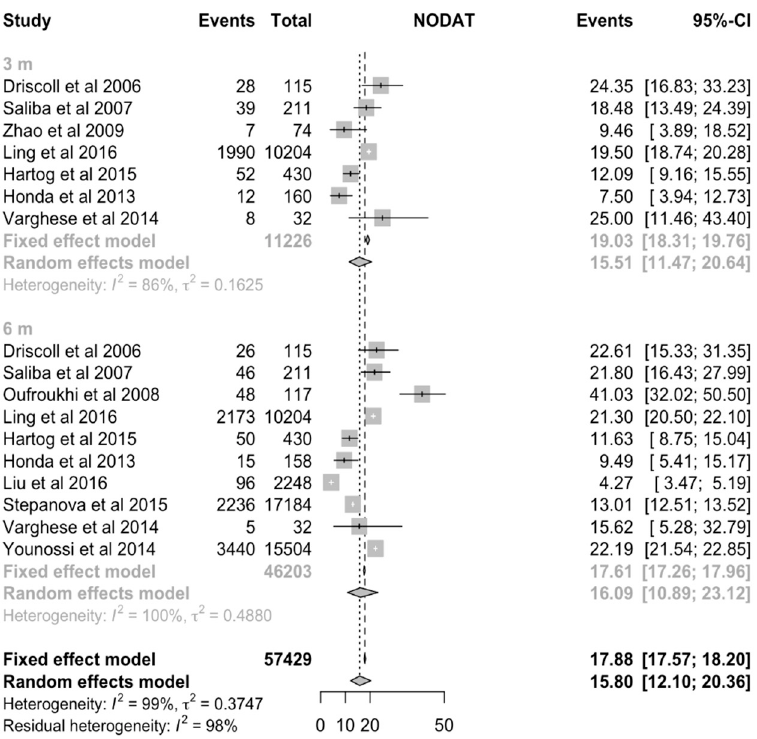
Figure 2. Incidence of New-Onset Diabetes After Transplantation (NODAT) at 3-months and 6-months After Liver Transplantation. CI = Confidence interval.